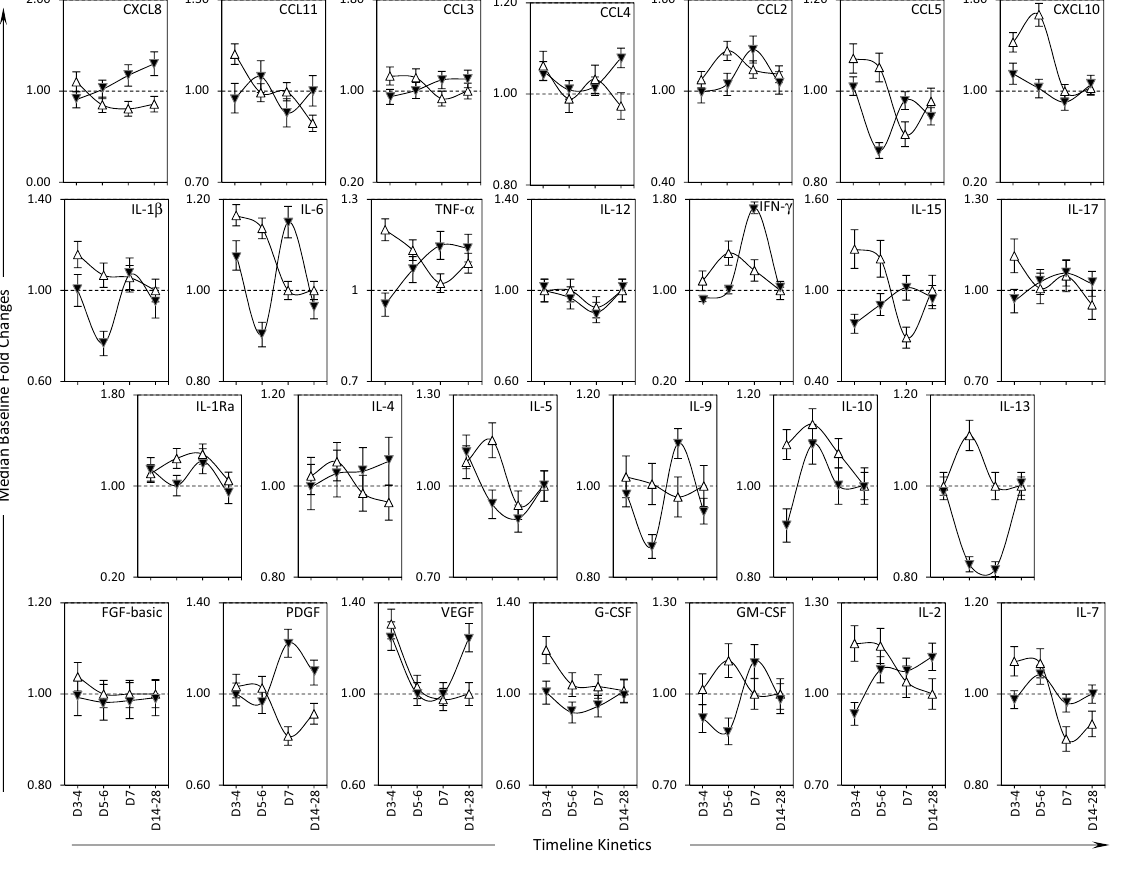
Figure 2. Timeline Kinetics of Serum Biomarkers in Patients with Autoimmune Disease According to the Neutralizing Antibody Status After Planned Primary 17DD-YF Vaccination. Panoramic timeline kinetics of serum chemokines (CXCL8, CCL11, CCL3, CCL4, CCL2, CCL5, CXCL10), pro-inflammatory cytokines (IL- 1β, IL-6, TNF-α, IL-12, IFN-γ, IL-15, IL-17), regulatory cytokines (IL-1Ra, IL-4, IL-5, IL-9, IL-10, IL-13), and growth factors (FGF-basic, PDGF, VEGF, G-CSF, GM-CSF, IL-2 and IL-7) in serum samples from Autoimmune Disease patients, categorized according to the PRNT status after primary 17DD-YF vaccination: AID/PRNT(−) (black filled inverted triangle, n = 32) and AID/PRNT(+) (white filled inverted triangle, n = 108). Measurements were carried out using the Luminex platform, according to manufacturer’s instructions as provided in Material and Methods. The results are expressed as median baseline fold changes ± variation at each time point along the kinetic follow-up (D3–4, D5–6, D7 and D14–28) according to the paired sample collected at D0. Data analysis was performed considering the baseline fold value = 1.0 as the reference for decrease (< 1.0) or increase (> 1.0) in biomarker levels along the kinetic